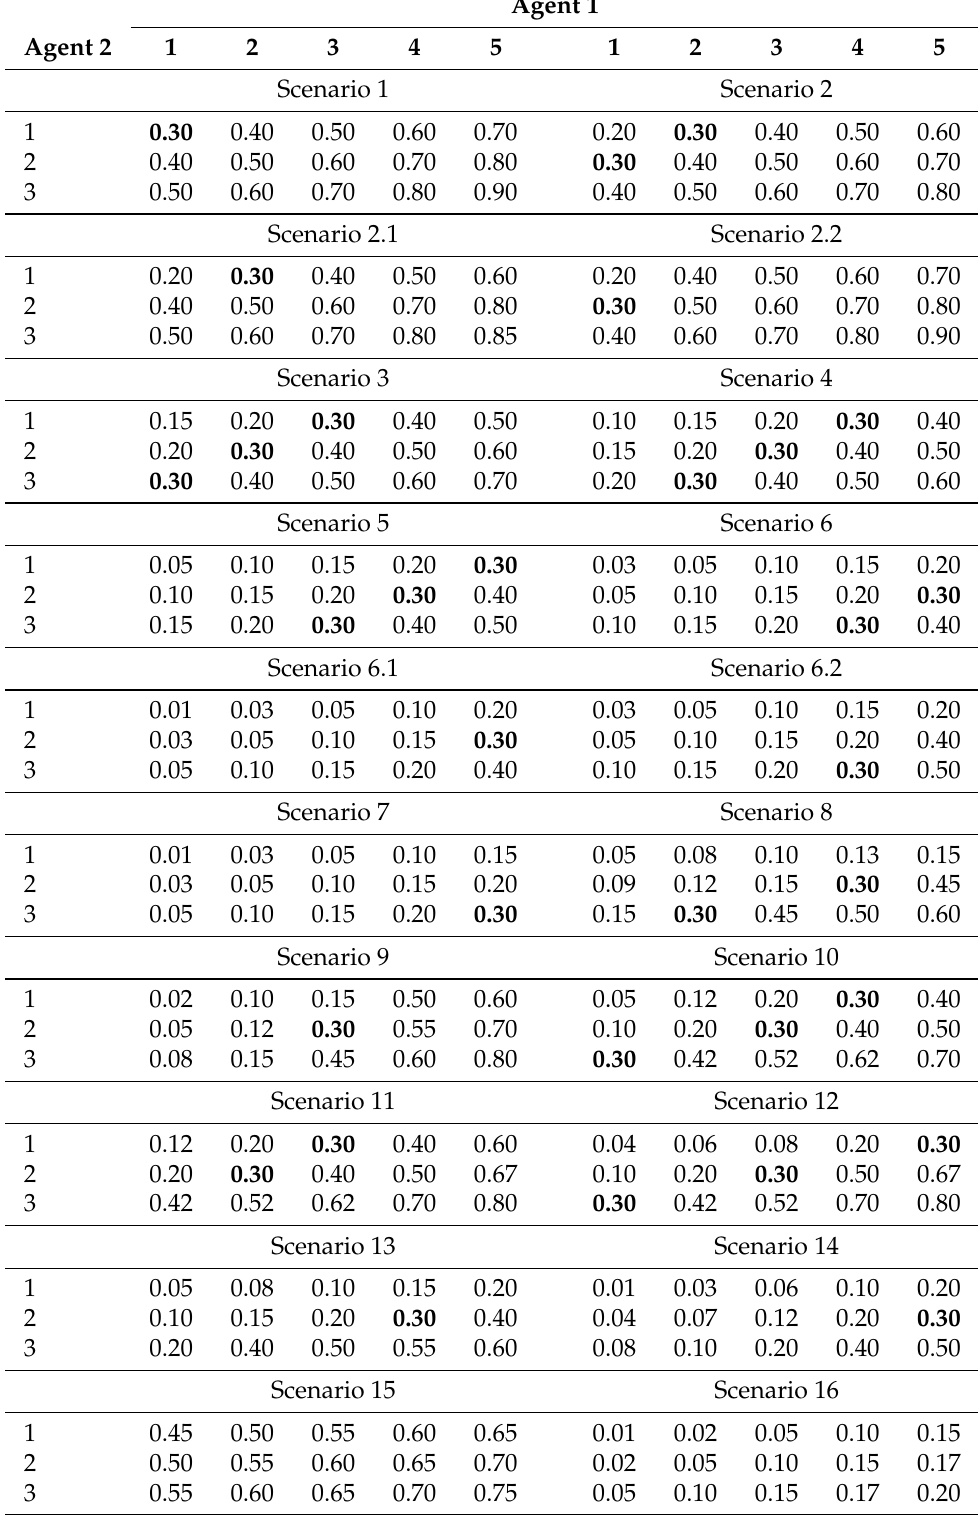
Table 1. Toxicity scenarios for the dual-agent combinations. The true MTC combinations are in